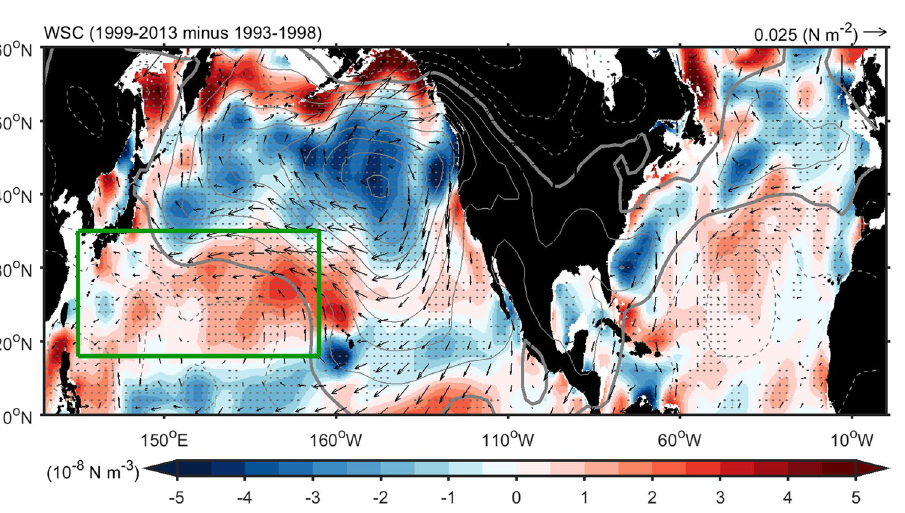
Figure 3. Monthly wind stress and wind stress curl anomalies. Ensemble average of monthly sea level pressure (contour), wind stress (vector) and wind stress curl anomaly (WSCA) difference (shading) (1999–2013 minus 1993–1998) from various data sets (NCEPr1, NCEPr2, ERAint, and JRA55). Gray dots indicate where results of WSCA difference are consistent in those data set. The green box indicates the region of the subtropical gyre (125°E–165°W;